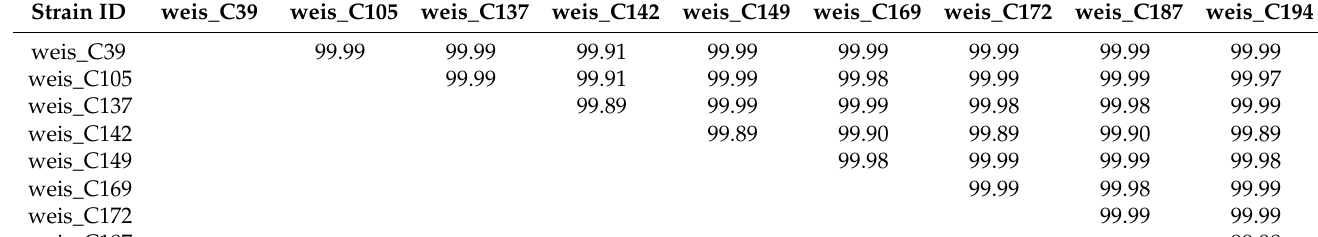
Table 2. OrthoANI values for the nine W. paramesenteroides isolates.